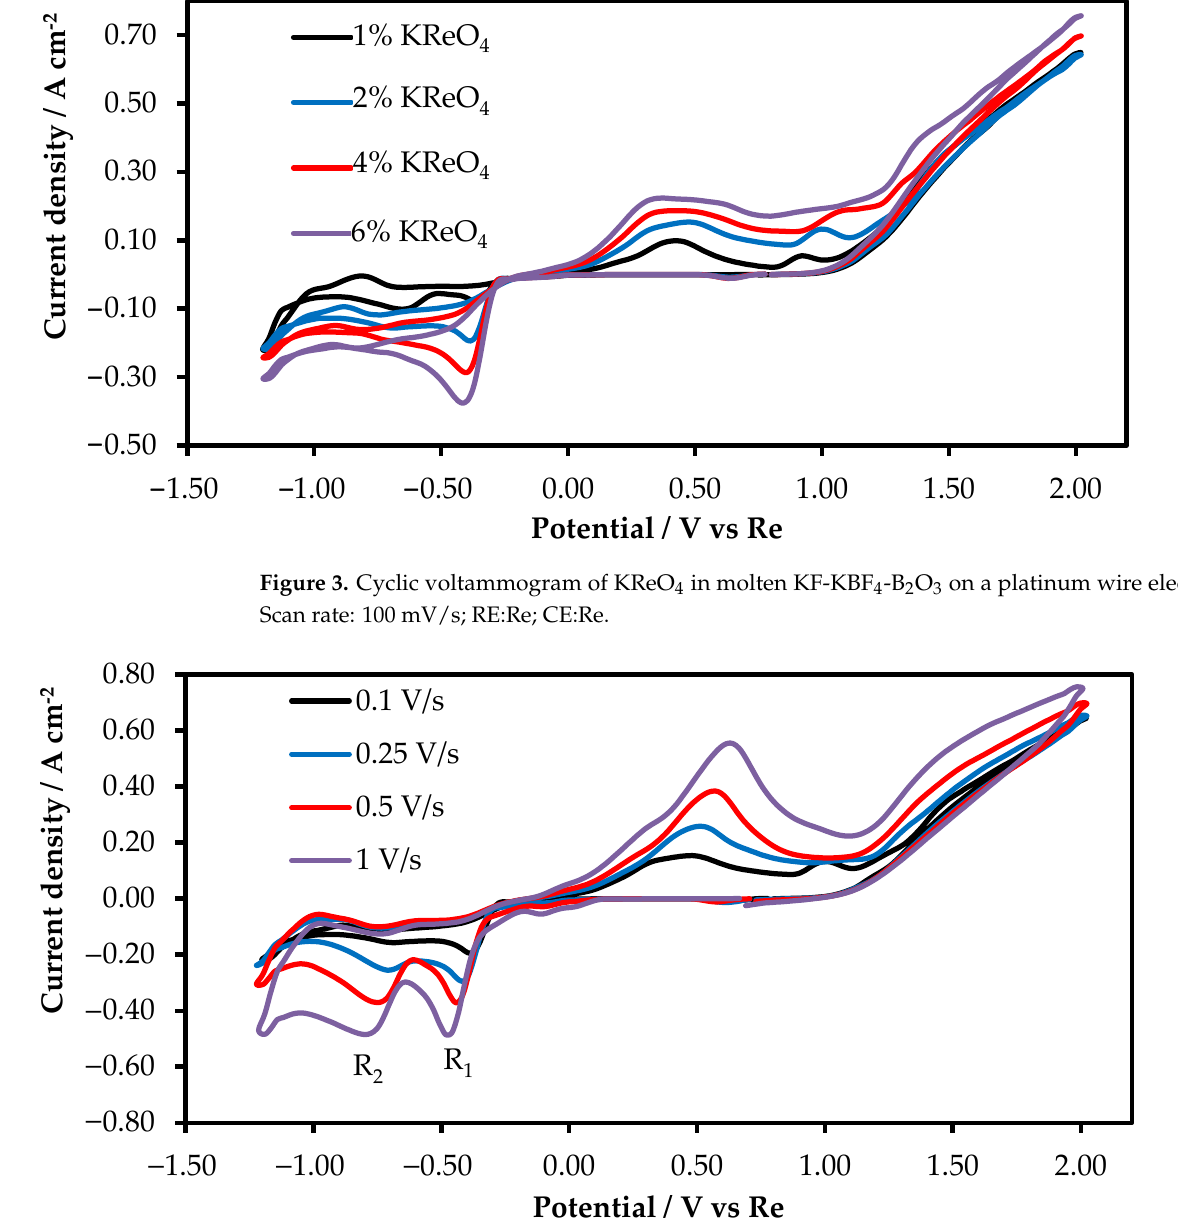
Figure 4. Cyclic voltammogram of 2 wt.% of KReO 4 in molten KF-KBF 4 -B 2 O 3 on a platinum wire electrode. RE:Re; CE:Re.